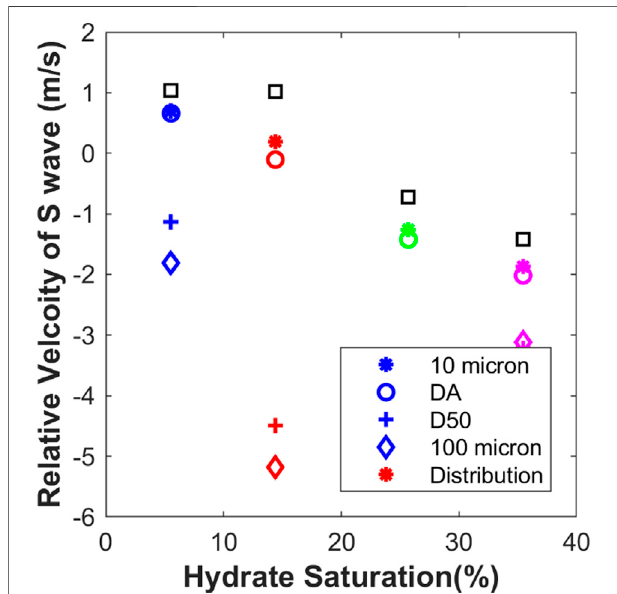
FIGURE 10 | Effect of gas bubble size and distribution on P wave velocity during hydrate formation in porous sediment.